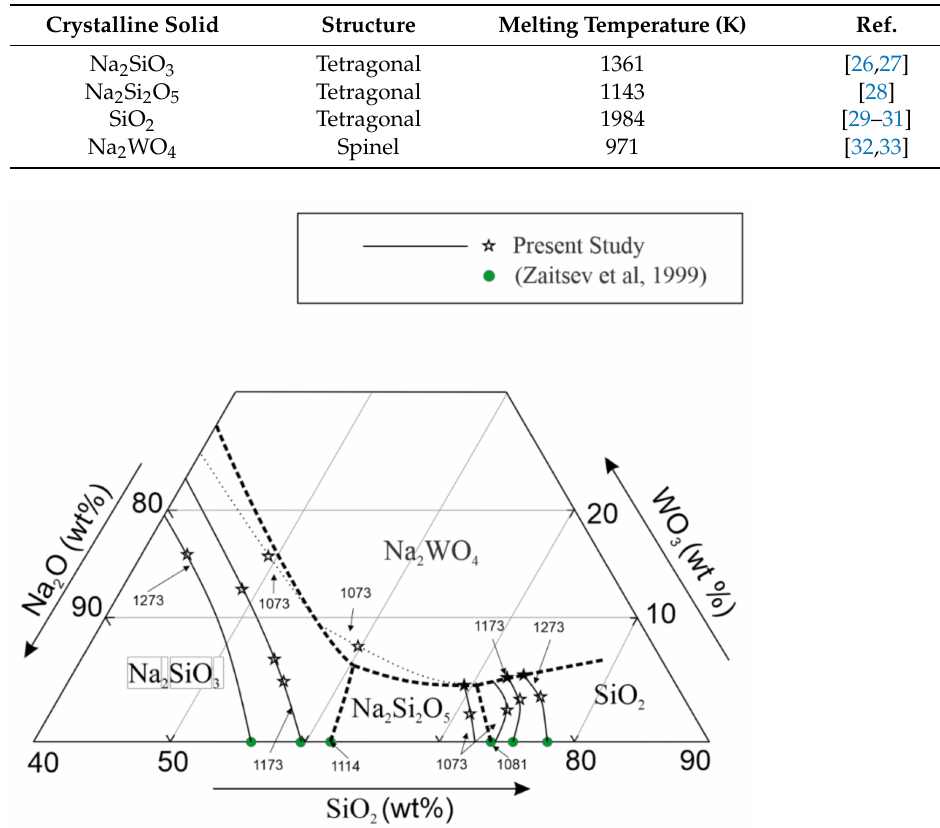
Figure 4. Newly determined isotherms at 1073 K (800 ◦ C), 1173 K (900 ◦ C), and 1273 K (1000 ◦ C) for the ternary phase diagram in the Na 2 O-SiO 2 -WO 3 system 25; faint dotted line: estimated